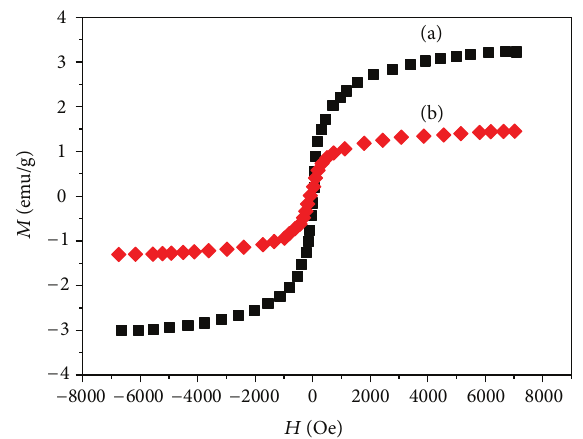
Figure6:Thecalibrationcurveoftheimmunosensorwith(a)Fe-Au MNPs-anti-CRP2/HRP and (b) HRP-anti-CRP2 signal